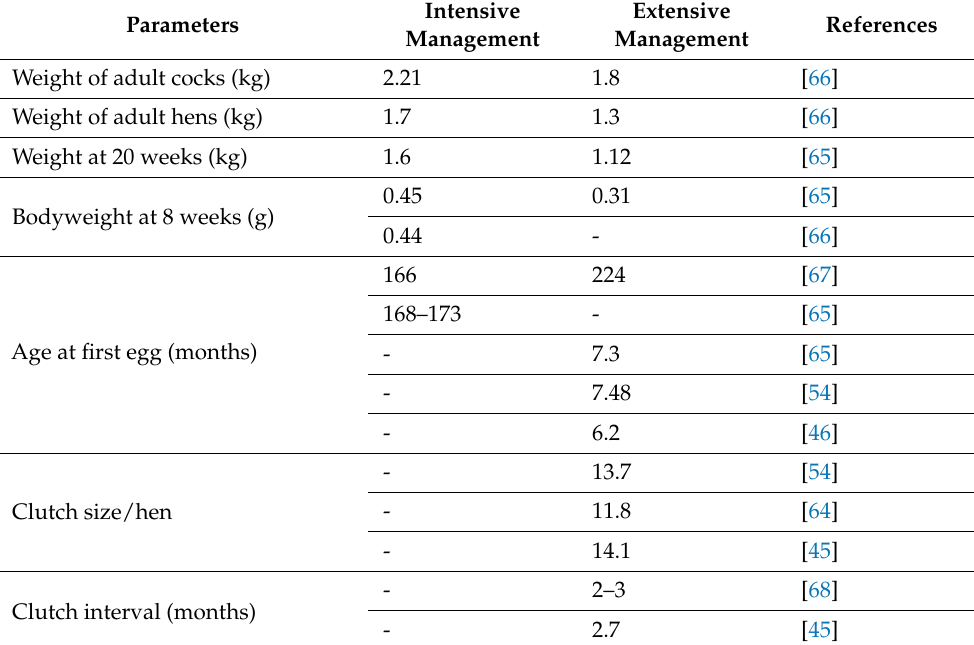
Table 4. Mean production and reproduction performance of the indigenous chicken